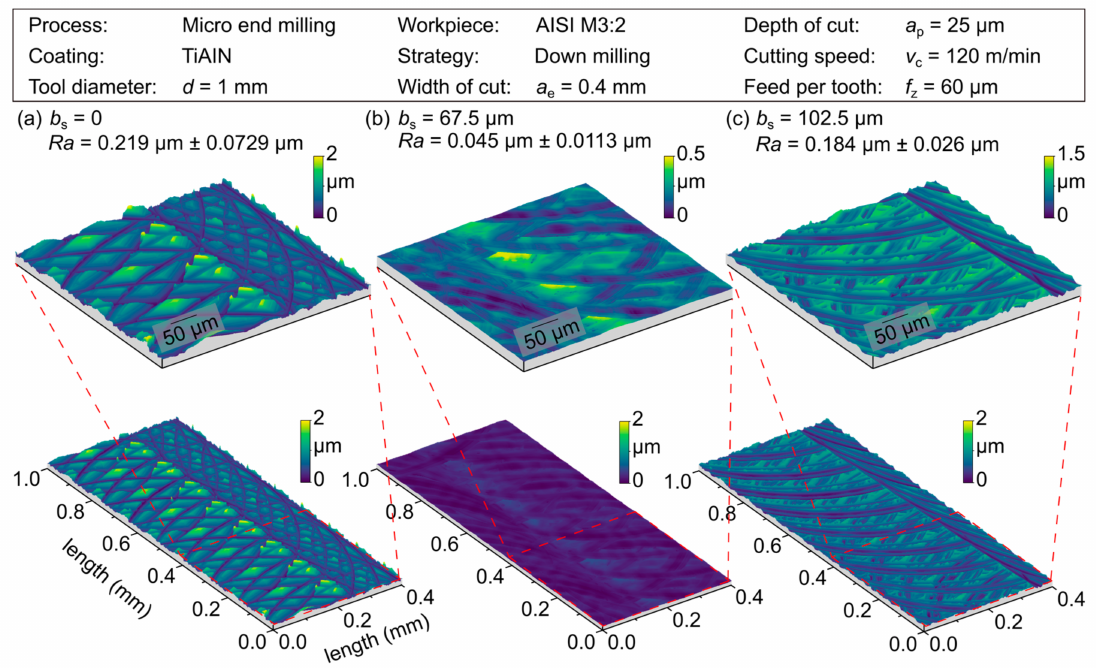
Figure 10. Surface topography for the parallel land b s = 0, 67.5, 102.5 µ m.